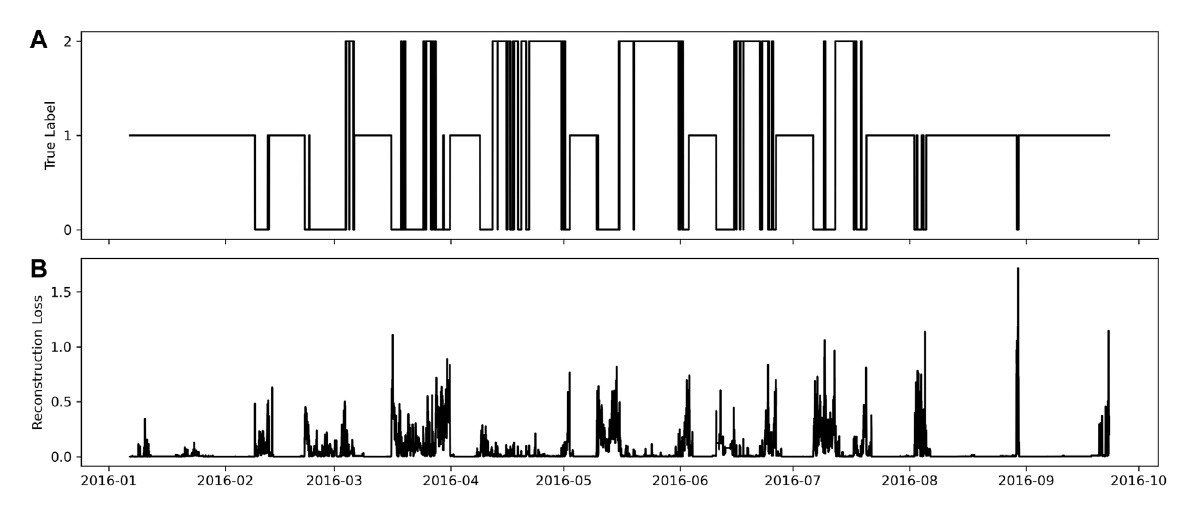
FIGURE 4 LSTM autoencoder network predictions for test magnetic fi eld timeseries data in 2016. (A) True region labels based boundary crossing list. The labels SH, SP, SW are magnetosheath, magnetosphere and solar wind, respectively. (B) Magnetic fi eld pro fi le reconstruction